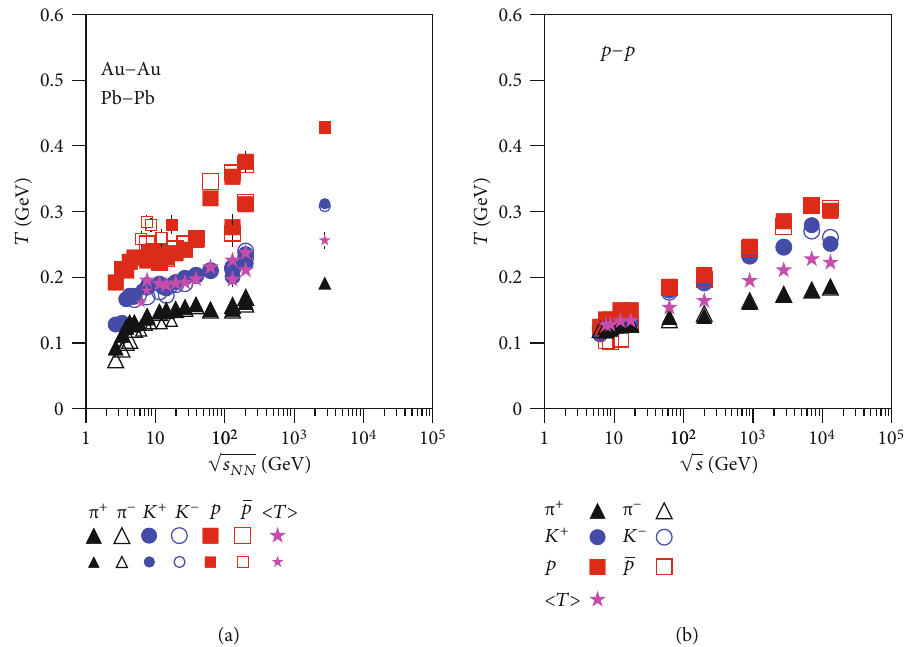
Figure 4: Excitation functions of T and h T i in (a) central Au-Au (Pb-Pb) collisions and (b) INEL pp collisions. The symbols corresponding to identi fi ed particles are extracted from experimental spectra, where the symbols with small size are used for Pb-Pb